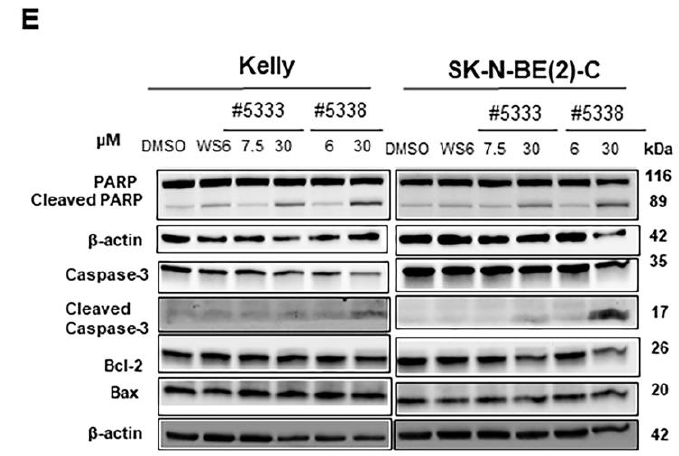
Figure 2. Compounds #5333 and #5338 inhibit the malignant phenotype of neuroblastoma cells in vitro. Colony formation assays measuring colony numbers at 2 weeks timepoint in ( A ) Kelly and ( B ) SK-N-BE(2)-C neuroblastoma cell lines. ( C ) BrDu assays measuring proliferation at compound IC50 concentrations for Kelly and SK-N-BE(2)-C cells. ( D ) Flow cytometry of apoptosis profiles of cells treated with #5333 (7.5 µ M) and #5338 (6 µ M), compared with untreated DMSO control treatment, using Annexin-V & 7-AAD stains. Bar charts depict cells in early or late apoptotic states as the percentage of total apoptotic cells. ( E ) Western blot analysis of changes in apoptotic effector proteins PARP, Caspase-3, Bcl-2, and Bax in response to #5333 or #5338 treatment. Values are mean ± SEM (n = 3). Asterisk (*) refers to comparison of treated groups to DMSO control groups. * p < 0.05, ** p < 0.01, *** p < 0.001, **** p < 0.0001, ns: non-significant. Statistical significance was determined using Student’s t-test. The uncropped blots are shown in Supplementary Materials of original Western Blot figures.